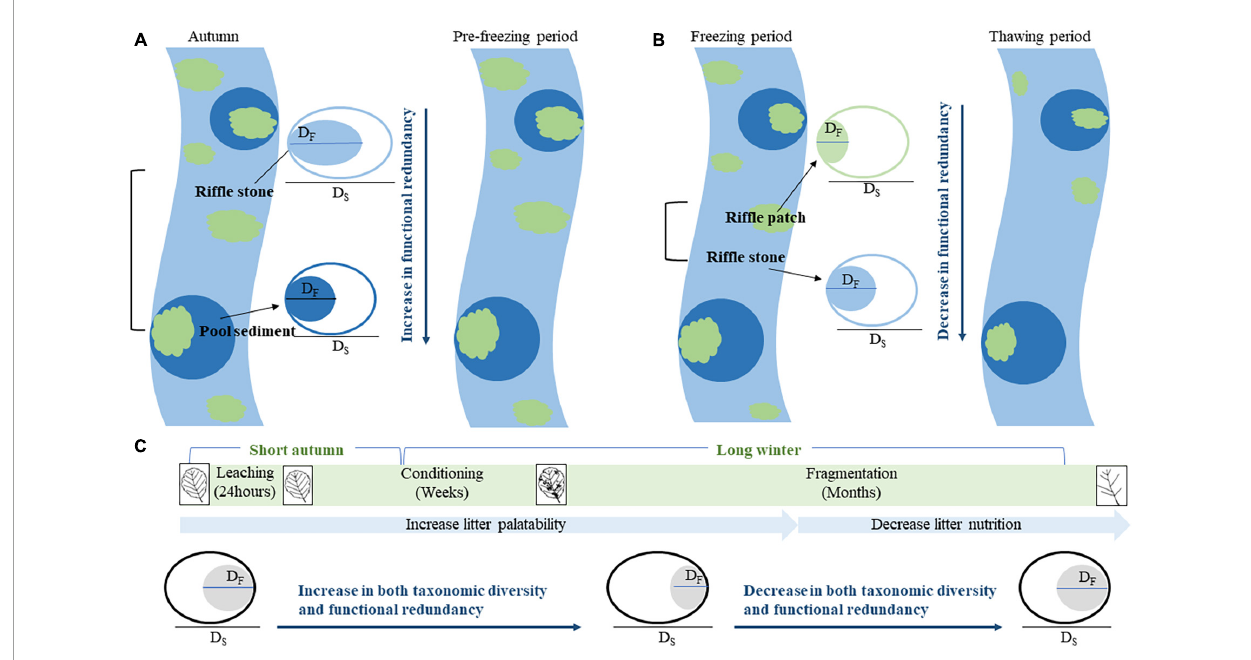
FIGURE1 A hypothesized variation of functional diversity and redundancy between four subhabitats (riffle stone, pool sediment, riffle litter, and pool litter) and between four periods (autumn, pre-freezing, freezing, and thawing periods). (A) The difference in functional redundancy between riffle stones and pool sediments; (B) the difference in functional redundancy between riffle sediments and riffle litters; (C) the temporal variation of functional redundancy from autumn to next spring. D S , taxonomic diversity, indicated by an open ellipse; D F , functional diversity, shown by a filled ellipse, D F ≤ D S . Functional redundancy = 1–D F /D S .